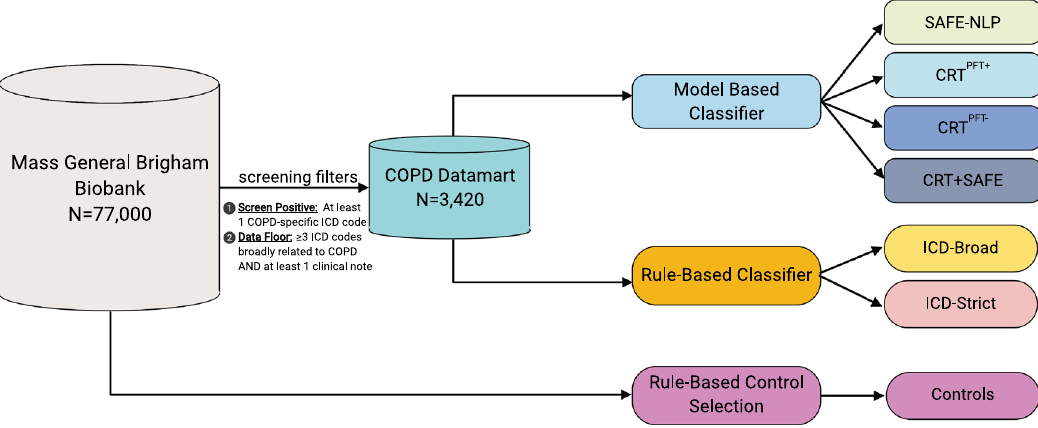
Figure 1. Overview of COPD datamart selection and developed